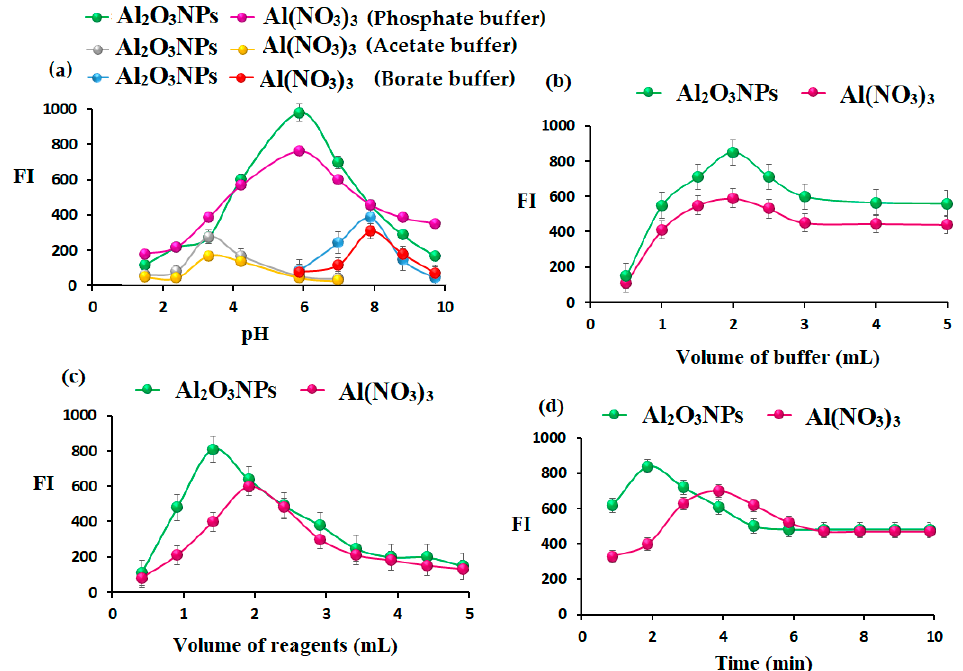
Figure 7. ( a ) Effect of pH using (acetate, phosphate, and borate buffers), ( b ) effect of volume of phosphate buffer pH 5.8, ( c ) effect of volume of Al 2 O 3 NPs and Al(NO 3 ) 3 , and ( d ) effect of response time for the determination of AMH using the two suggested AMH-Al 2 O 3 NPs and AMH-Al(NO 3 ) 3 systems.